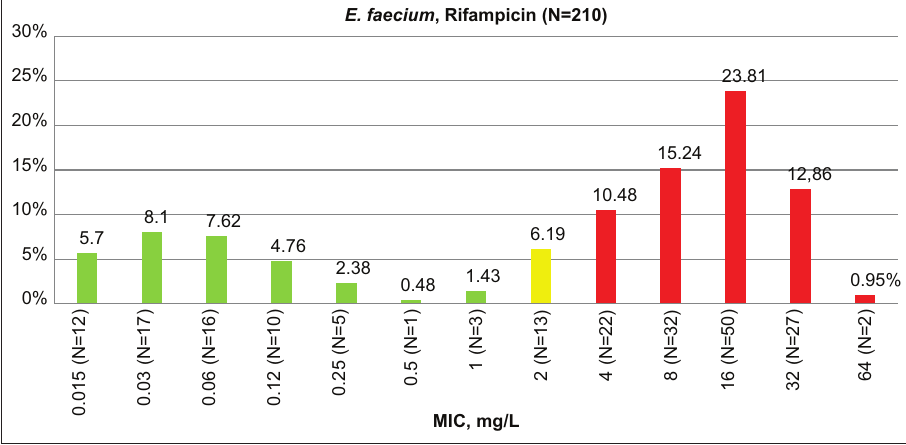
Figure-4: Rifampicin minimum inhibitory concentration distribution among Enterococcus faecium isolates. Green columns – percent of susceptible isolates, yellow – intermediate resistant, red – resistant (CLSI 2021 breakpoints), N – number of isolates.